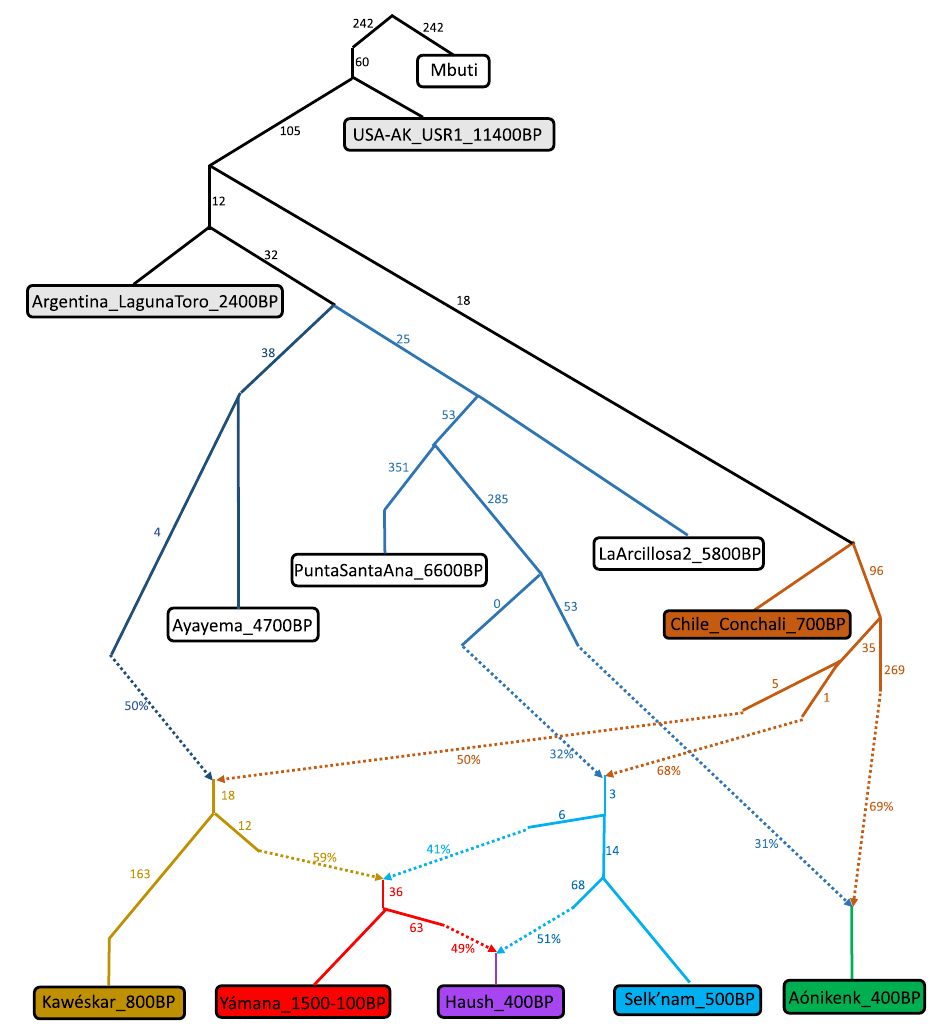
Fig. 3 Admixture graph model summarizing key fi ndings. Maximum | Z -score| = 2.6 for a difference between observed and expected f- statistics (| Z | = 2.7 restricting the analysis to transversions). The model presented fi ts only after adding small proportions of deeply diverging ancestry into PuntaSantaAna_6600BP and Kawéskar_800BP (splitting before the radiation of Native Americans), which we hypothesize re fl ects not real ancestry but rather technical artifacts due to these samples being shotgun sequenced and not UDG treated, causing them to be attracted to the outgroup (without modeling these edges, shown in Supplementary Fig. 6, the maximum | Z -score| is 5.1, but this drops to 3.3 with only transversions). Dashed lines indicate admixture between two different lineages with percentages being the admixture proportions. Numbers on solid lines are genetic drift with units of F ST × 1000. Z -scores were determined from standard errors obtained from